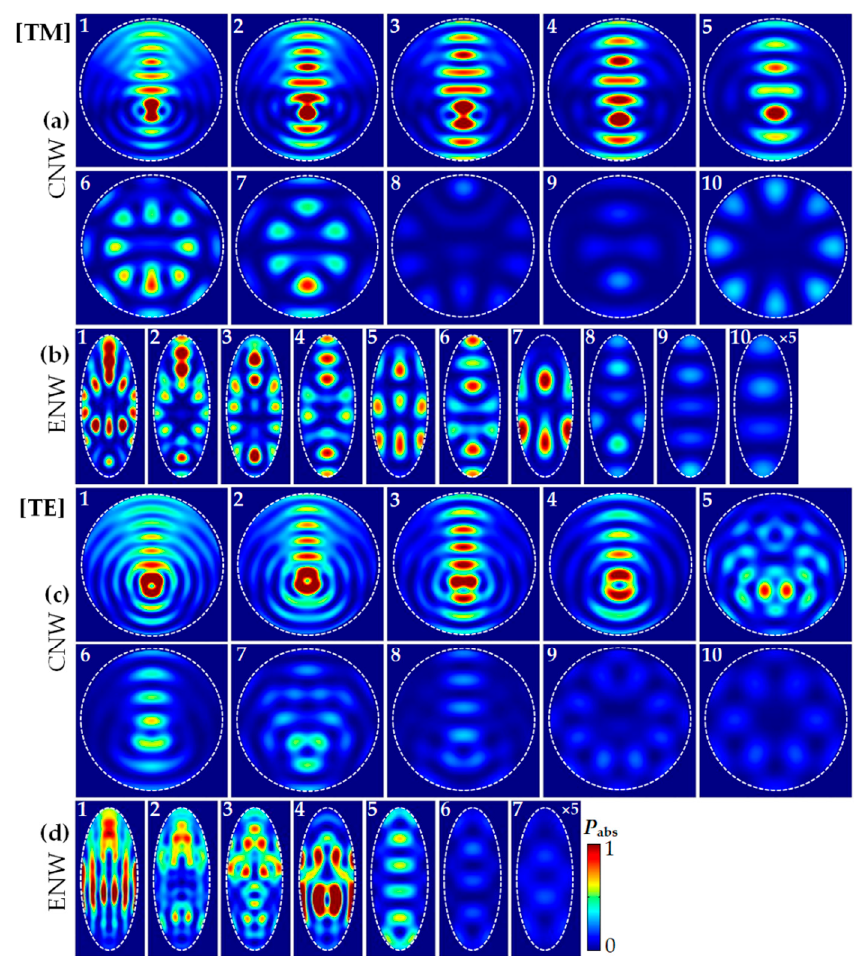
Figure 4. The representative normalized absorption mode profiles ( P abs ) for the CNW and ENW at the absorption peaks indicated by Arabic numerals in Figure 2a,b and Figure 3: ( a , b ) for TM and ( c , d ) for TE light illumination (with an identical color scale); ( a , c ) for the CNW with D = b = 500 nm and ( b , d ) for the ENW with a = 200 and b = 500 nm, respectively. Note that P abs in b (10) and d (7) are properly magnified for better illustration.